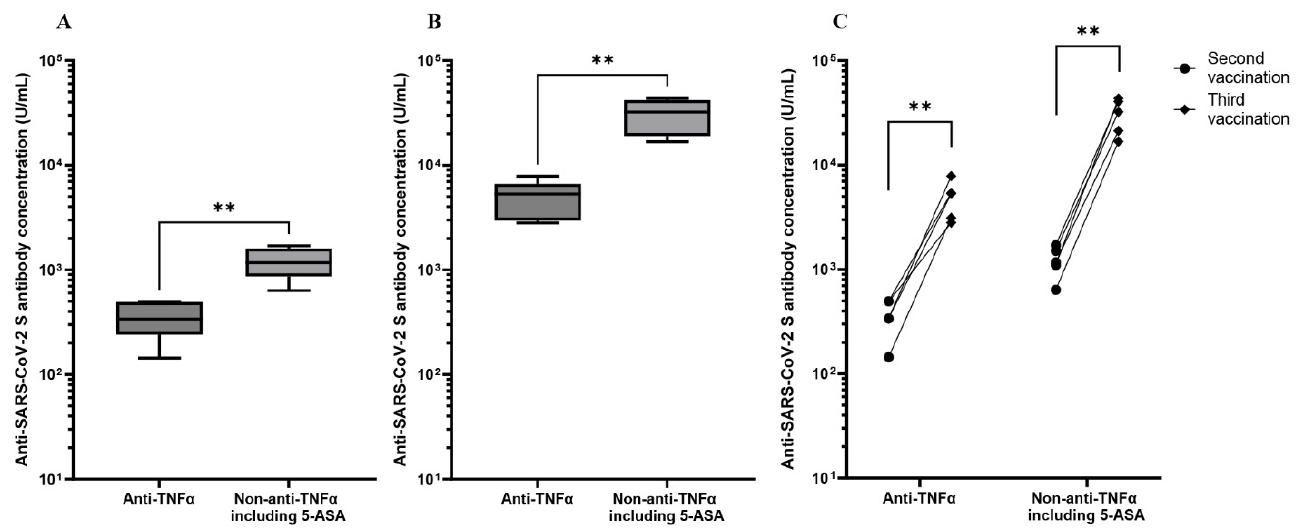
Figure 3. Serological response to the third vaccination. Ten patients were evaluated for the response to the third dose (anti-TNF α : 5, non-anti-TNF α including 5-ASA: 5). ( A ) Antibody titers in patients treated with anti-TNF α are significantly lower than those treated with non-anti-TNF α including 5-ASA 3–9 weeks after the second vaccination. ( B ) Antibody titers in patients treated with anti-TNF α are significantly lower than those treated with non-anti-TNF α including 5-ASA 3–9 weeks after the third vaccination. ( C ) Antibody titers 3–9 weeks after the third vaccination are significantly higher than those at the same point after the second vaccination, regardless of IBD medications. TNF = tumor necrosis factor, 5-ASA = 5-aminosalicylic acid. For comparisons of different vaccine groups in panels ( A , B ), the unpaired non-parametric Mann–Whitney test was used. For comparisons at different time points of the same vaccine groups in panel ( C ), paired two-tailed t-tests were used. For both tests, p -values < 0.05 were considered significant. ** indicates p -values < 0.01.